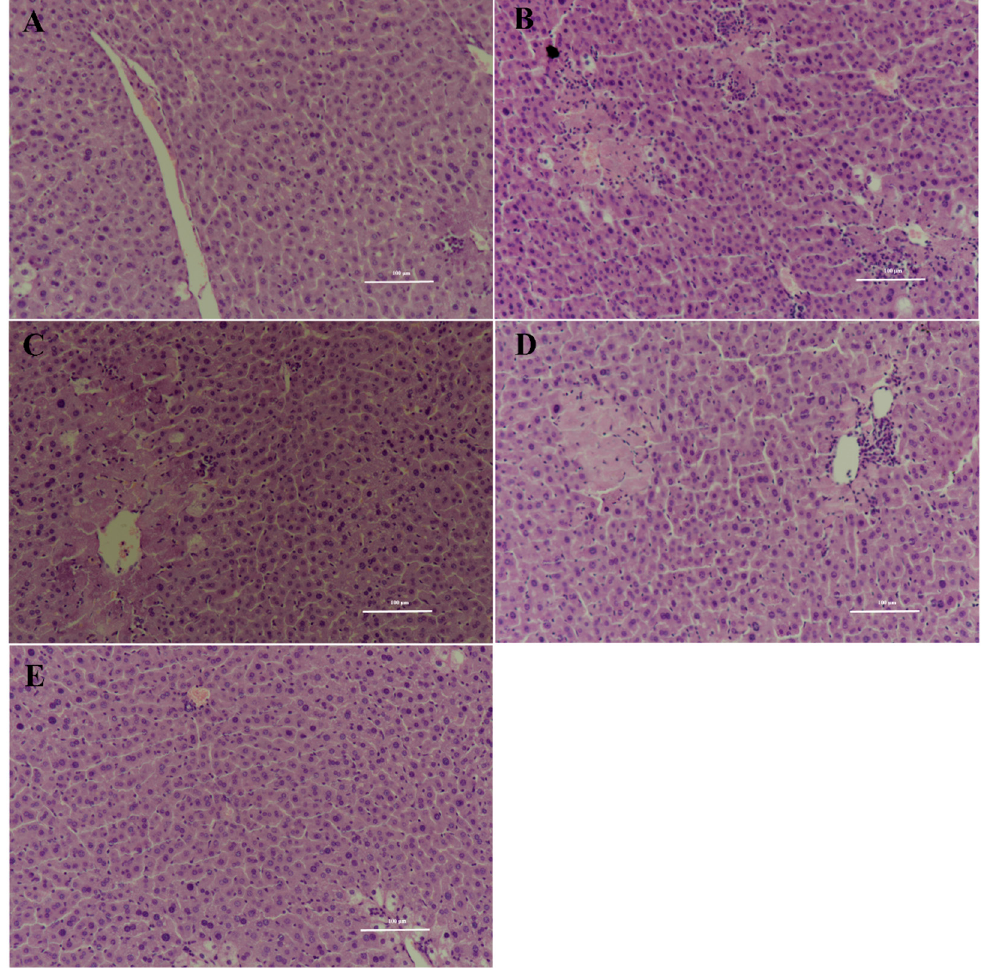
Figure 7. Effects of free 6-shogaol and SMs on hepatic morphological analysis ( × 200 H&E): Blank group ( A ), CCl 4 -model group ( B ), Positive drug (100 mg/kg) and CCl 4 group ( C ), Free 6-shogaol (100 mg/kg) and CCl 4 group ( D ), SMs (100 mg/kg) and CCl 4 group ( E ). The scale bar: 100 µ m.